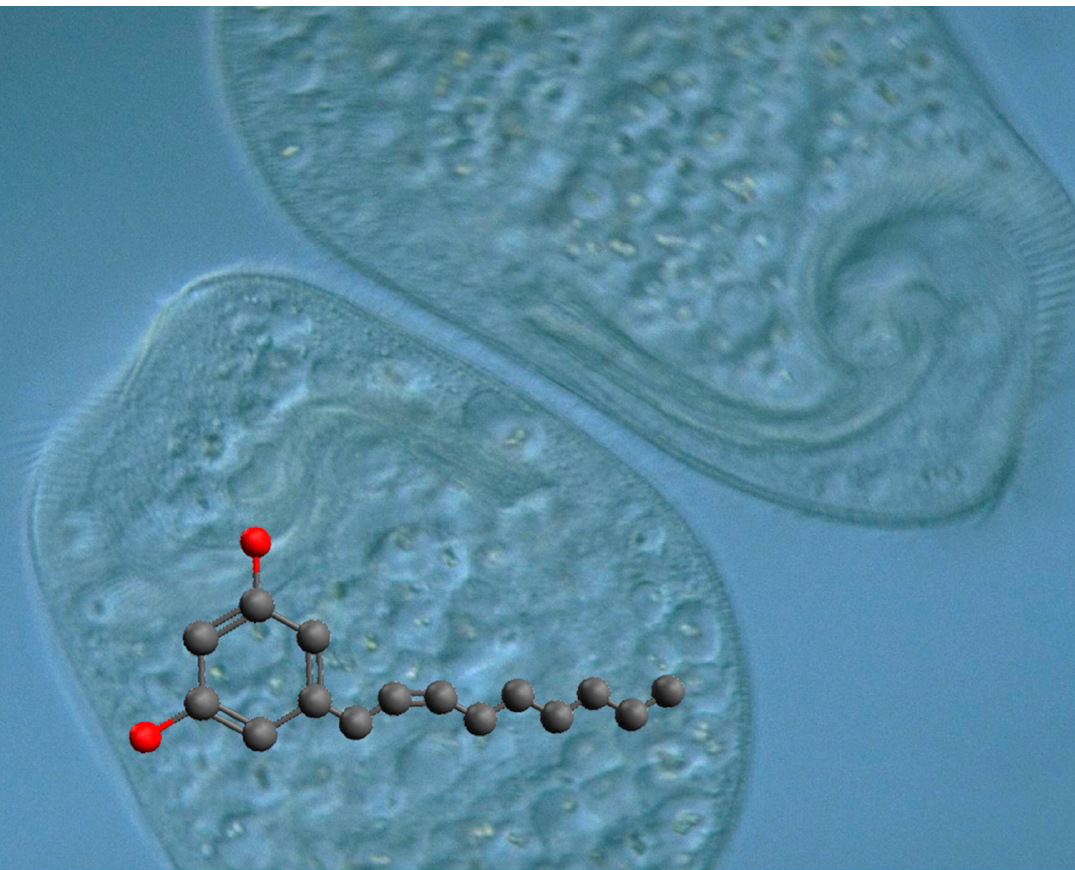
Figure 2. Climacostomum virens and molecular structure of its secondary metabolite, climacostol. Original microphotograph of C. virens by Y. Tsukii (Protist Information Server, http: // protist.i.hosei.ac. jp /